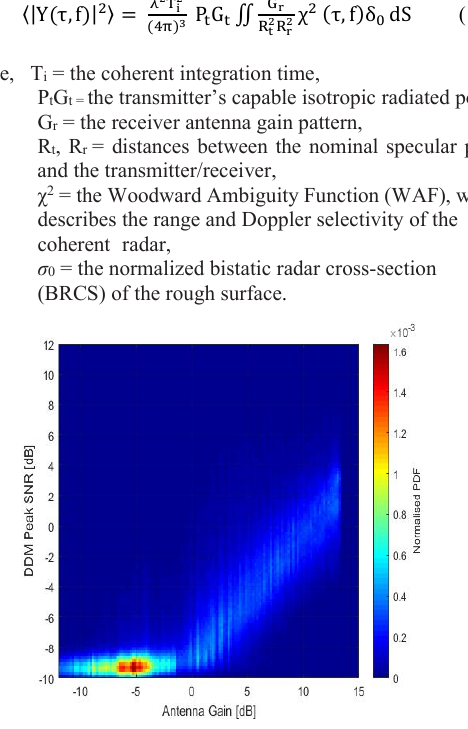
Figure 4. SNR and Antenna Gain Histogram for the DDM